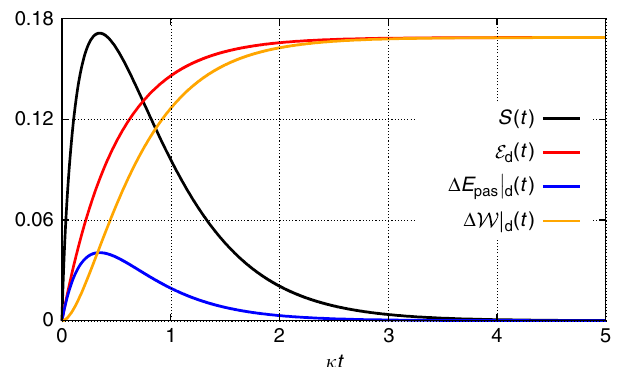
Fig. 3 Entropy and energy of a cavity mode interacting with a squeezed bath. Entropy, ergotropy and energy changes for a single cavity mode prepared in the vacuum state that interacts with an outside bath in a squeezed-vacuum state (Fig. 2b) obtained by a numerical integration of the master equation. The energies are given in units of ħ ω and the entropy in units of k B . Parameters: ω = 10 κ and squeezing parameter r = 0.4, κ being the decay rate of the